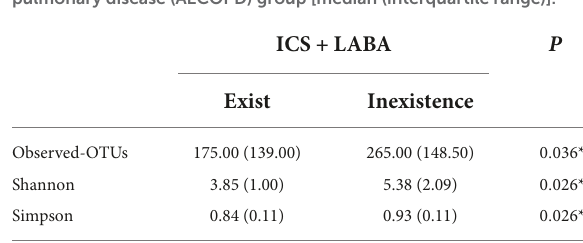
TABLE 2 Differences in alpha diversity of airway microflora and ICS + LABA in the acute exacerbation of chronic obstructive pulmonary disease (AECOPD) group [median (interquartile range)].